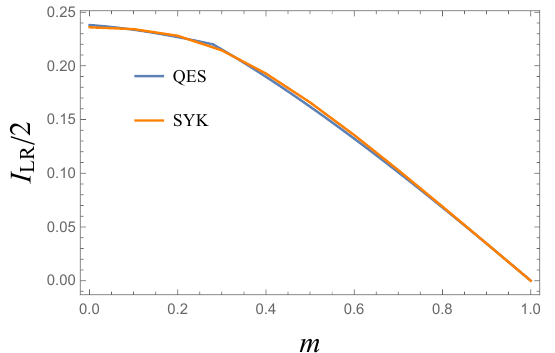
Figure 9. Comparison of the Von Neumann mutual information computed in this section using the QES prescription and the Renyi-2 mutual information compued in section 2.3 for the SYK model. We choose the parameters S 0 = 0 . 2324 N , C = 0 . 28 , c = 0 . 5 , and β J = 50 . The two results are in good agreement. In the bulk calculation, the phase transition is sharp, while in the SYK calculation it is smoothed out.